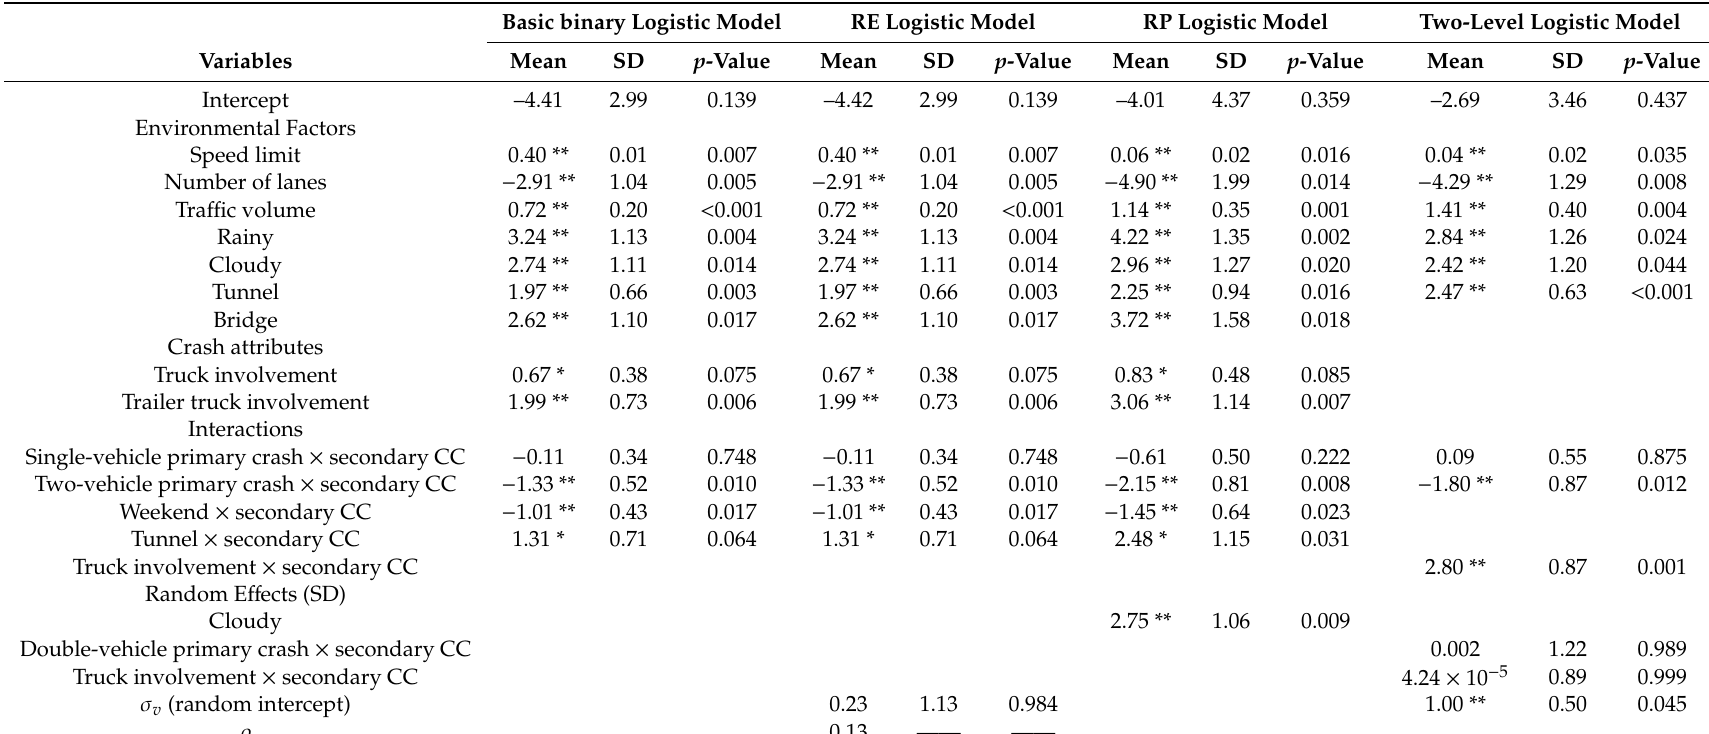
Table 2. Estimation results for the proposed four model